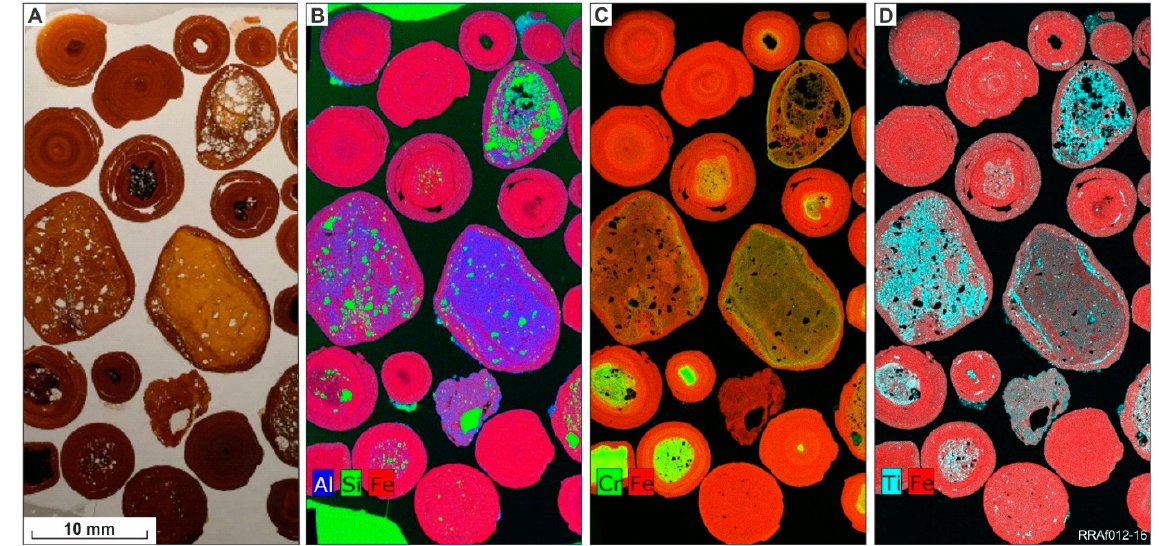
Figure 9. Ternary diagrams showing composition of ferruginous nodules and pisoliths in terms of goethite, hematite and quartz and goethite, kaolinite and quartz.